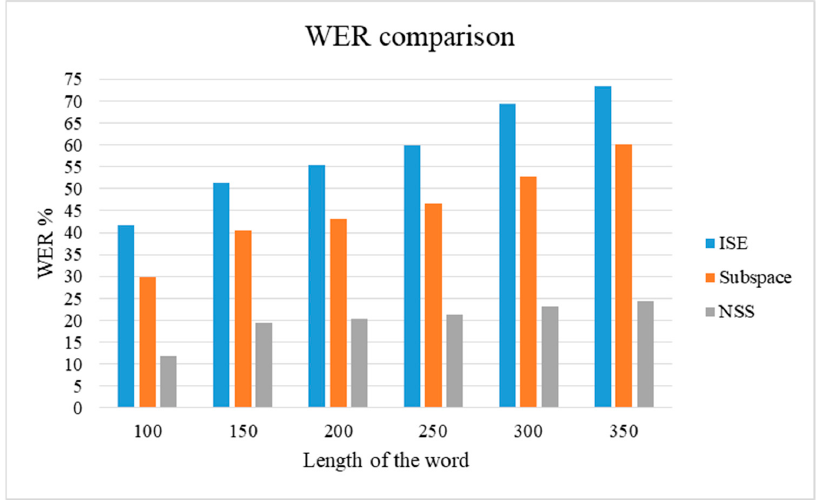
Figure 10. WER comparison of typical SE algorithms.